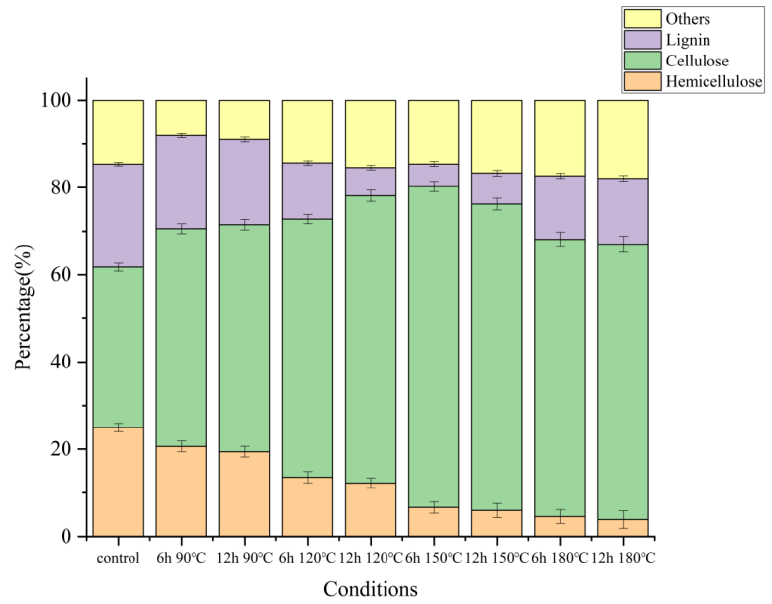
Figure 3. Chemical composition of wheat straw solid residues obtained from various DES pretreat- ment conditions.